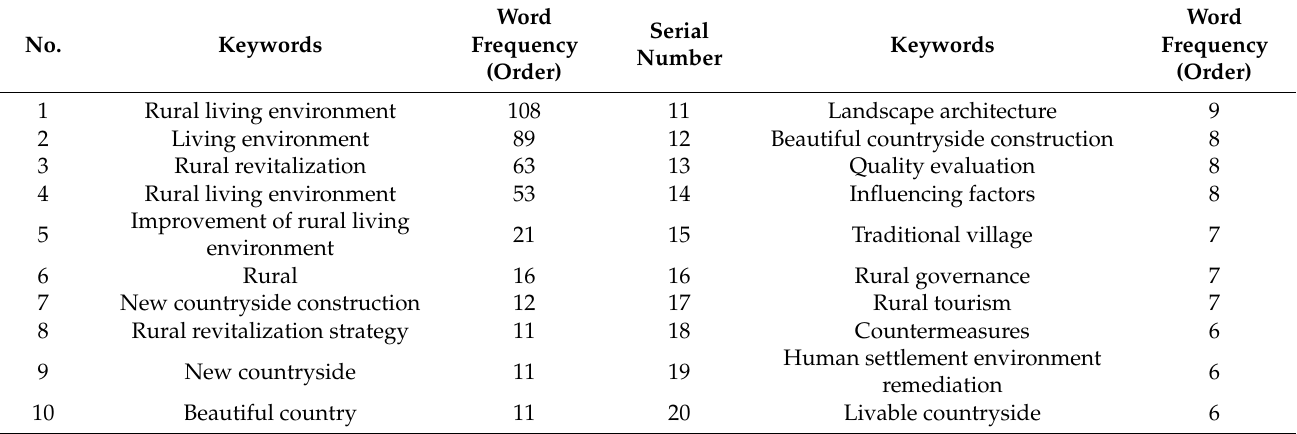
Table 3. Statistics of high-frequency keywords in rural human settlement environment research.